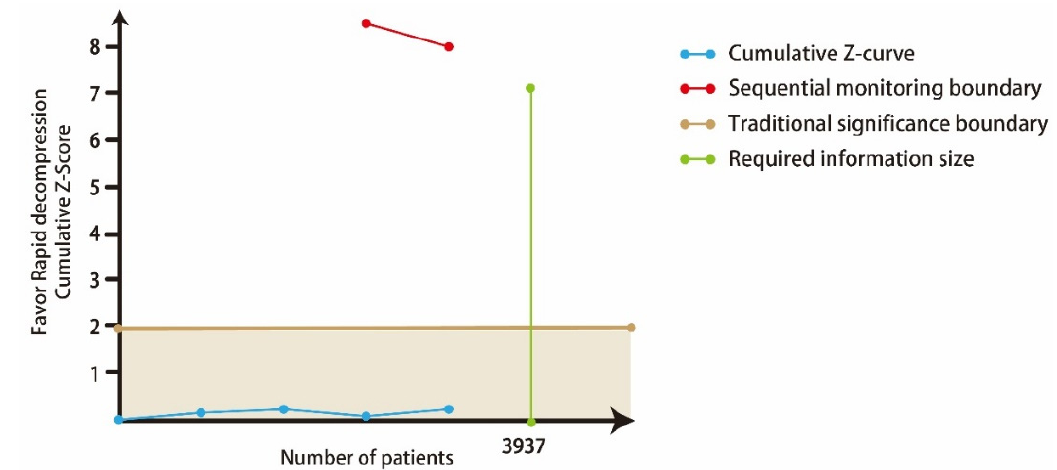
Figure 5. Sensitivity analysis for hematuria. CI, confidence interval.